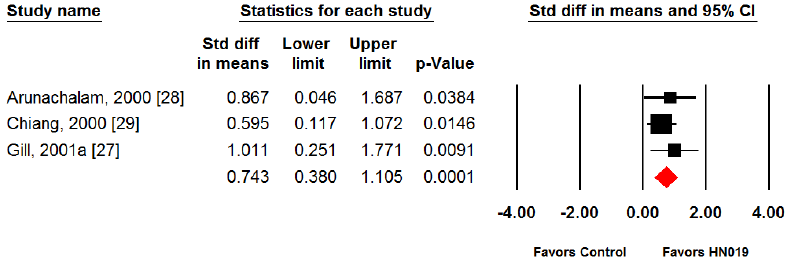
Figure 2. Forest plot of polymorphonuclear phagocytic capacity with consumption of B. lactis HN019 vs. control. Random effects meta-analysis using the standardized mean difference (SMD) statistic. The SMD of B. lactis HN019 relative to control is plotted for each study. A pooled estimate of SMD (diamond) and 95% confidence interval (diamond width) summarizes the effect size. Effects to the left of 0 indicate greater polymorphonuclear (PMN) phagocytic capacity with control; effects to the right of 0 indicate greater capacity with B. lactis HN019. When the horizontal bars of an individual study,